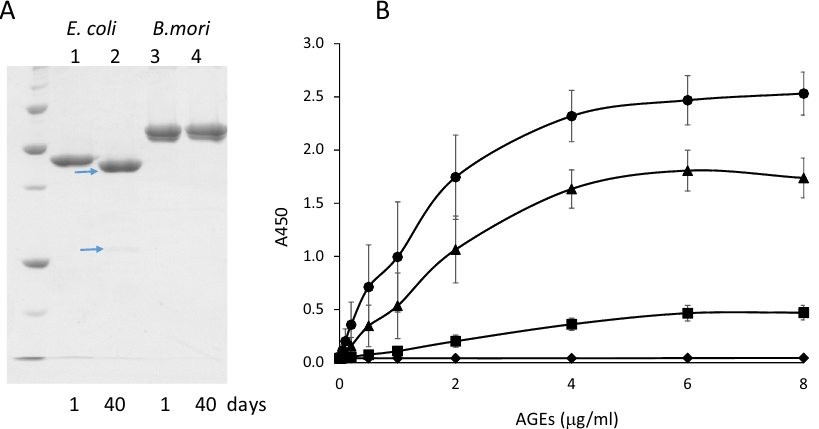
Figure 2. Characterization of sRAGE from transgenic silkworms. ( A ) Stability of sRAGE during storage at 4 °C. Forty days after purification, 10 μ g of protein was applied to SDS-PAGE followed by CBB staining. Lanes 1 and 2: sRAGE expressed in E. coli ; lanes 3 and 4: sRAGE expressed in MSGs of transgenic silkworms. Lanes 1 and 3: 1 day storage; lanes 2 and 4: 40 days of storage. Arrows indicate the degraded sRAGE. ( B ) Binding ability of sRAGE from silkworms to different AGEs after 1 year of storage. ⦁ : fructose-AGEs; ▴ : ribose-AGEs, ◼ : glucose- AGEs, ⬧ : control BSA (without glycation). Values are means and SEs of three wells from three independent